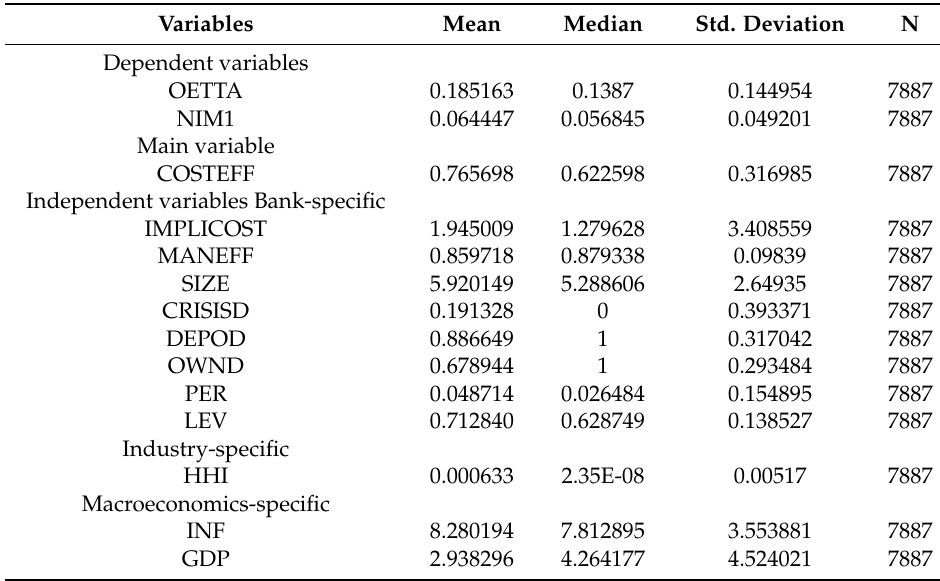
Table 2. Descriptive